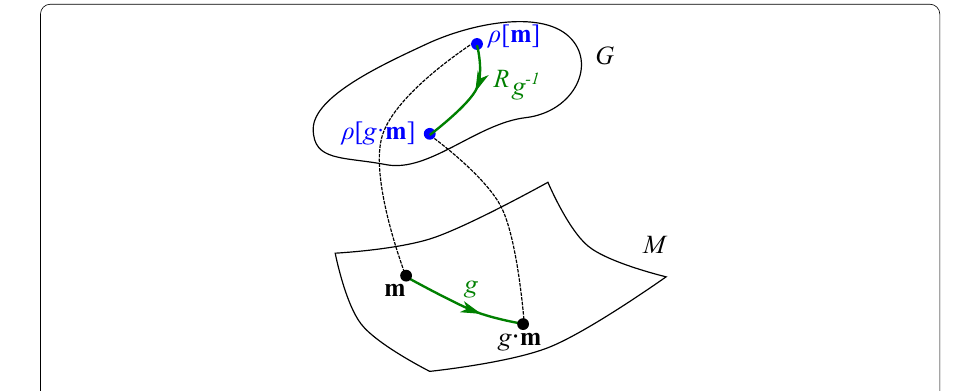
Fig. 20 Invariance condition (86). R is the right translation